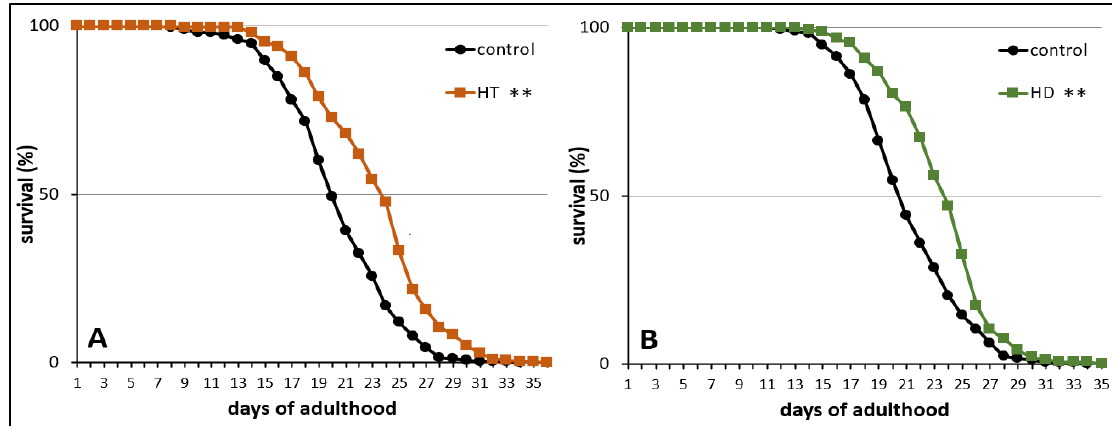
Figure 3. Life prolonging effects of HT and HD in wild type. The survival curves of control and polyphenol treated nematodes are shown. Survival is expressed as a percentage of the initial population per day. The curves represent three independent trials with a total of 250 and 286 nematodes in the control and HT treated nematodes, respectively ( A ) and two independent trials with a total of 172 and 144 nematodes in the control and HD treated nematodes, respectively ( B ). Statistical significance was calculated by log-rank test; differences compared to control were considered significant at p < 0.001 (**).